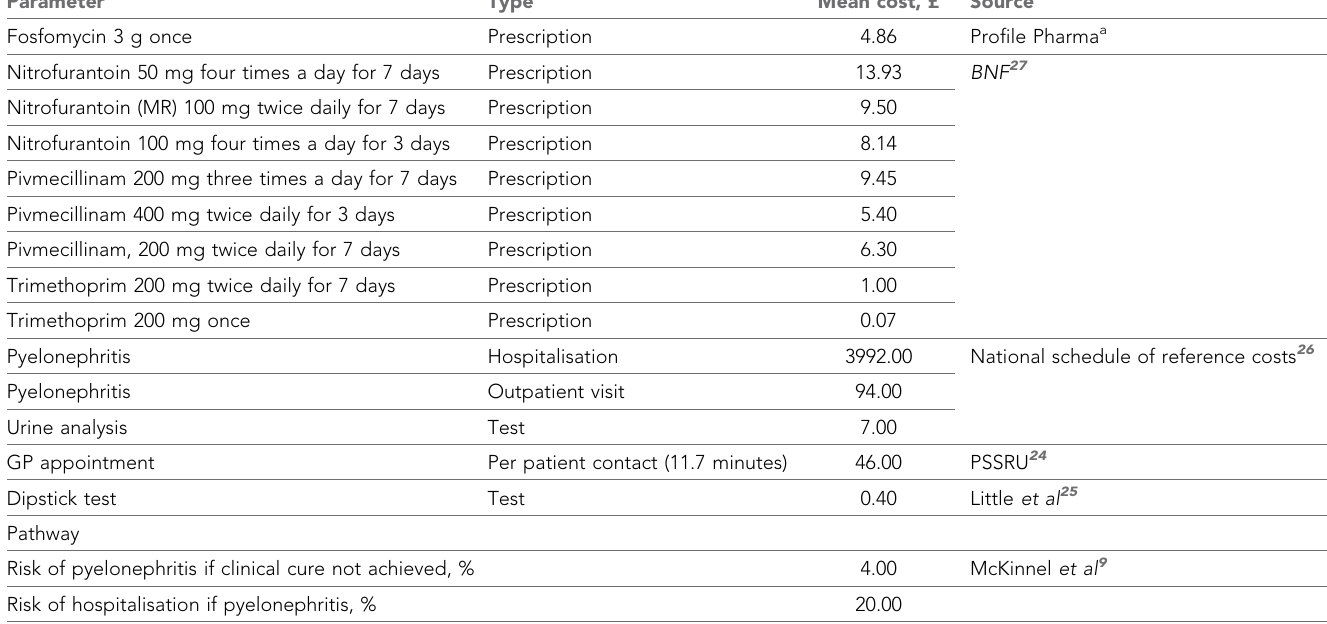
Table 2. Model parameters, including costs and treatment pathways, used in the